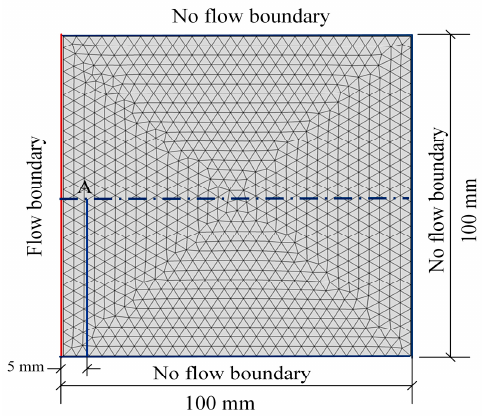
Figure 4. Numerical calculation model.